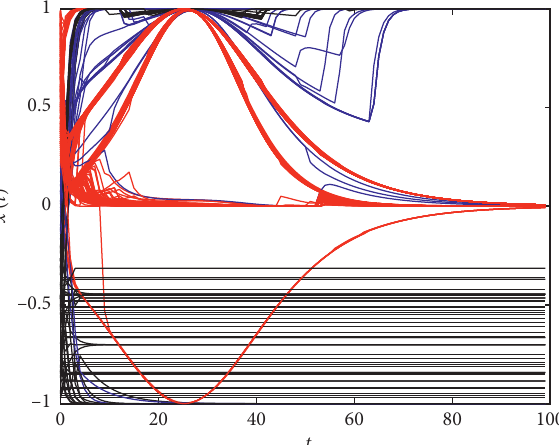
Figure 6: Evolution of individual opinions